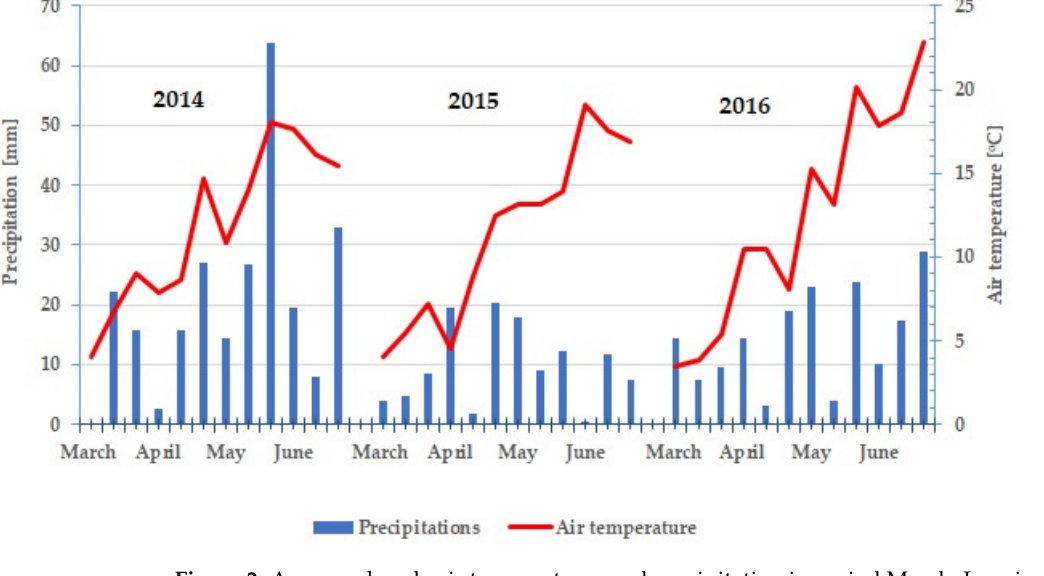
Figure 2. Average decade air temperatures and precipitation in period March–June in study years (2014–2016). Table 1. Values of the Selyaninov hydrothermal coefficient (HTC).